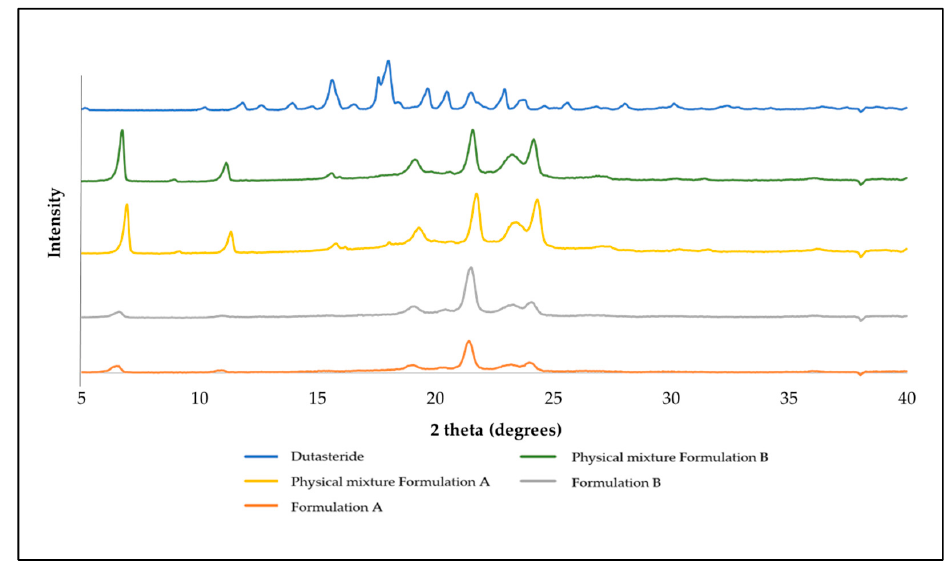
Figure 3. XRD results for DST (dutasteride) alone, the physical mixture of the formulation and freeze-dried Formulation A and Formulation B DST-LNP.